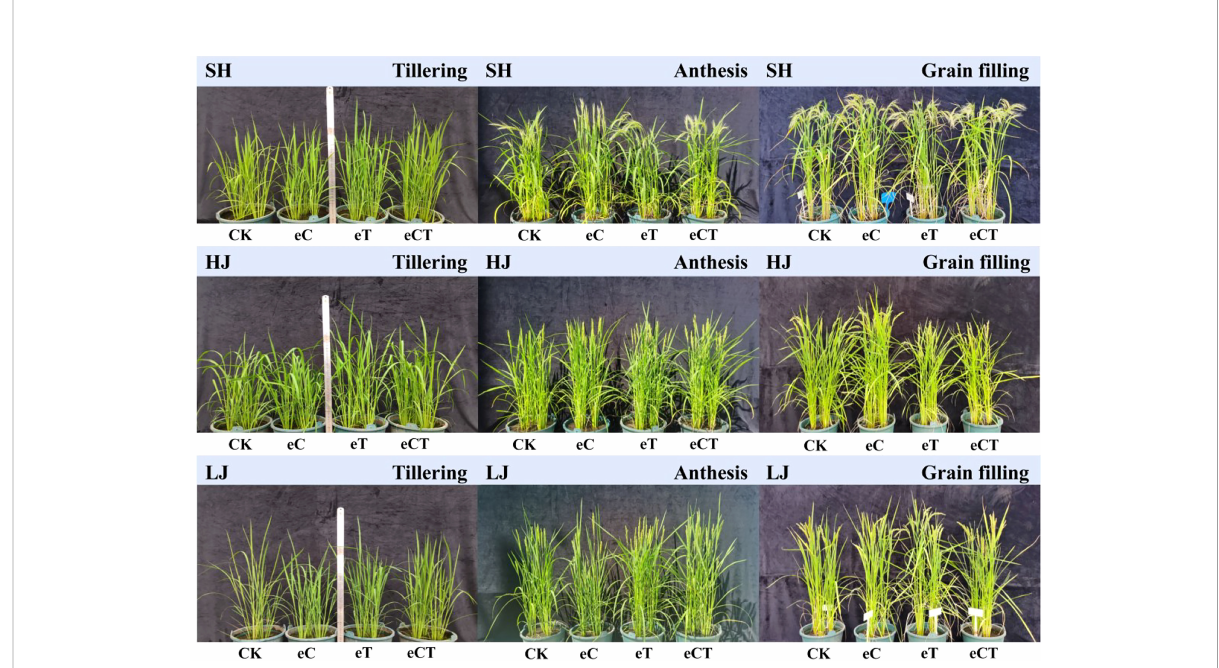
FIGURE 1 The rice growing conditions under different treatments during the stages of tillering, anthesis and grain fi lling (control, ambient conditions; eC, eCO 2 concentration; eT, elevated air temperature; eCT, the combination of elevated air temperature and [CO 2 ]) at three growth stages (tillering, anthesis and grain fi lling). SH, HJ and LJ refer to three rice cultivars Shishoubaimao, Hejiang 19, and Longjing 31,